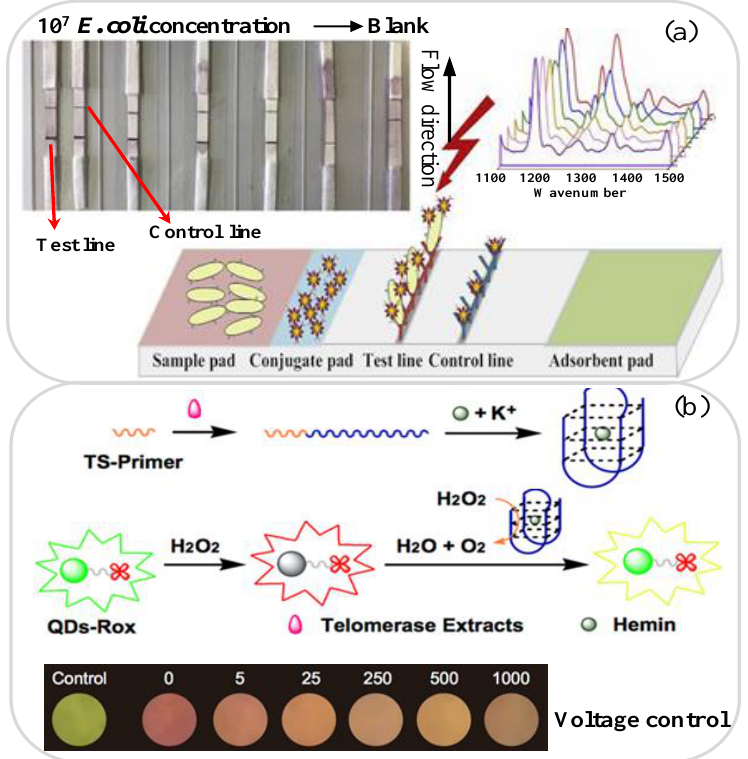
Figure 4. ( a ) μPAD-LFIA platform with SERS detection-coupled immunomagnetic enrichment for E. coli detection. Reprinted with permission from ref. [126]. Copyright 2019 Elsevier. ( b ) Lab-on-paper device with fluorescent probes for telomerase activity assay in urine for bladder cancer diagnosis. Reprinted with permission from ref. [132]. Copyright 2019 Elsevier.